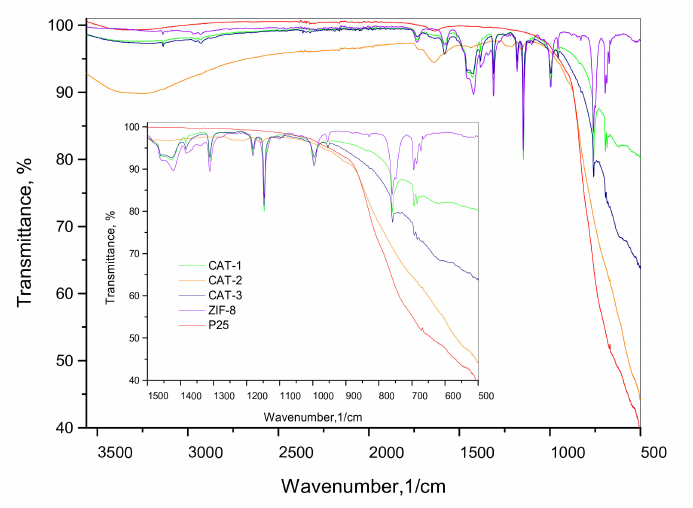
Figure 2. IR spectra of the studied series of